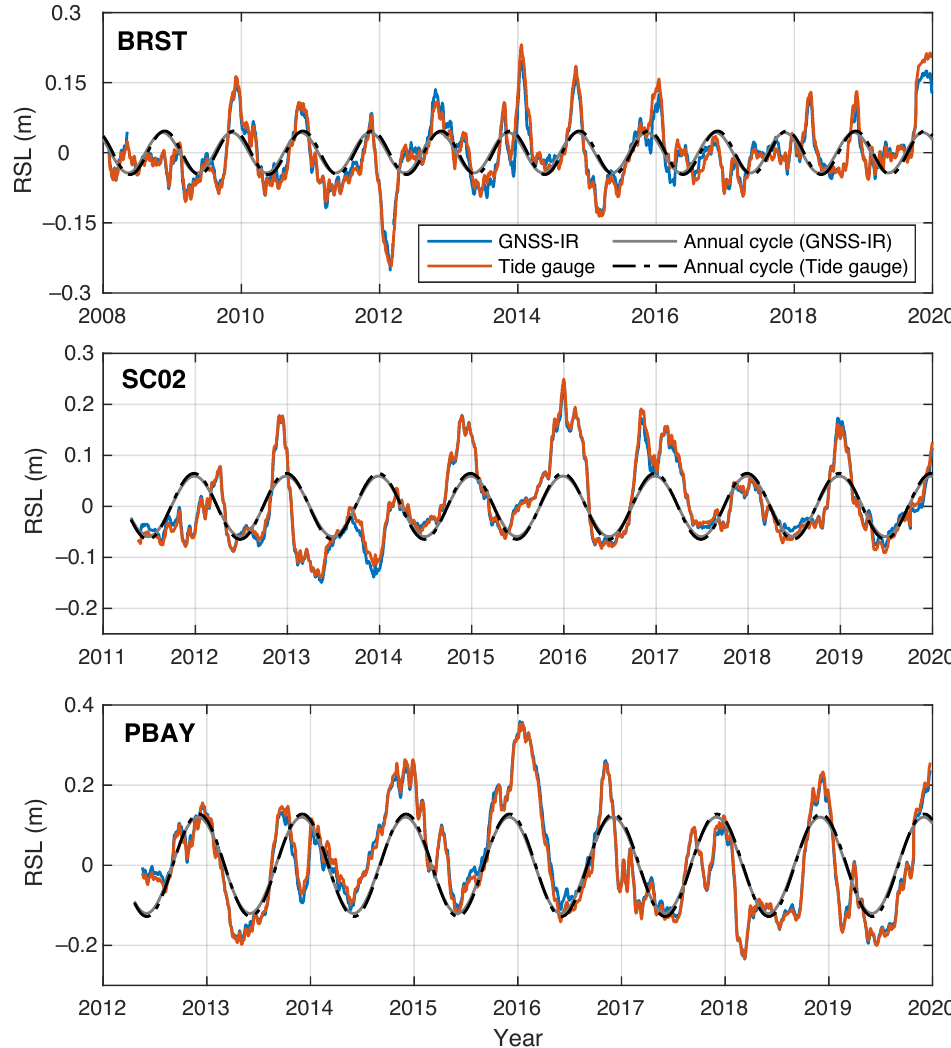
Figure 2. Time series of smoothed relative sea levels from GNSS-IR and tide gauge, and the corresponding fitted annual cycle, showing close agreement between measurements from the two observing